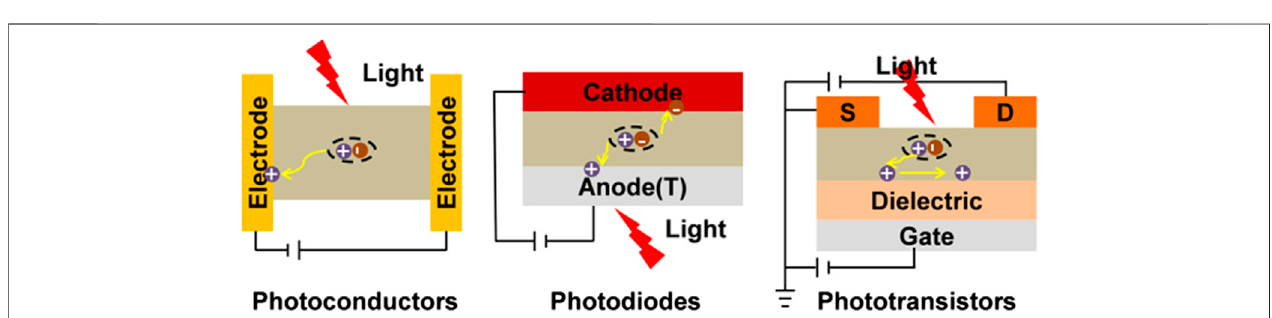
FIGURE 2 | Schematic illustrations of typical photoconductors, photodiodes, and phototransistors. T, S, and D stand for transparent, source, and drain, respectively. Reprinted with permission from Chem. Mater., 2019, 31, 6359-6379. Copyright 2019 American Chemical Society.